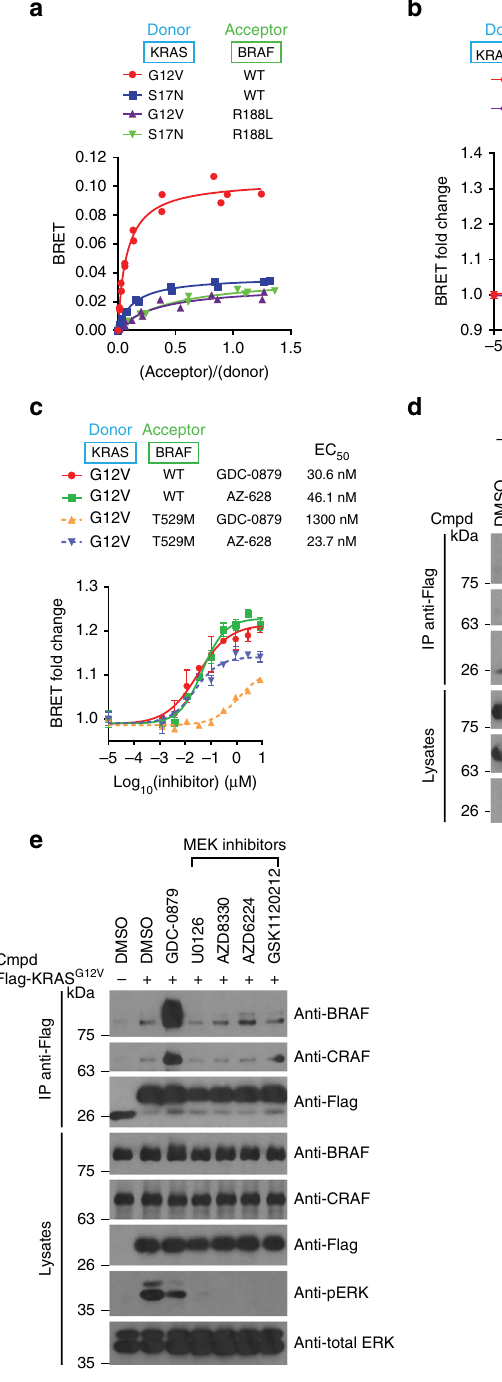
Fig. 1 RAF inhibitors promote RAS − RAF complex formation. a Validation of the KRAS − BRAF BRET biosensor by titration experiments. KRAS donor constructs comprised an N-terminal RlucII tag, while the BRAF acceptor constructs included an N-terminal GFP10 moiety. KRAS G12V − BRAF pair produced a strong and reproducible BRET signal that fi tted a hyperbolic function, indicating a speci fi c interaction. b The BRET signal emitted by the KRAS G12V − BRAF biosensors can be induced by RAF inhibitors in a dose-dependent manner. BRET fold-changes are presented separately for type I and type II inhibitors (left and right panel, respectively). c Mutation of the BRAF gatekeeper residue (T529M) in BRET probes abolishes GDC-0879 induced, but not AZ-628-induced KRAS G12V -BRAF interaction. EC 50 s for each dose-response curve are indicated. d Six bona fi de RAF inhibitors and three off-target inhibitors enhance the association of Flag-tagged KRAS G12V with endogenous BRAF and CRAF as measured by co-IP (left panel). GDC-0879 treatment also stimulates the association of NRAS G12V and HRAS G12V with endogenous BRAF and CRAF. Cells were treated with 10 µ M of the indicated compounds. e MEK inhibitors do not induce KRAS G12V -BRAF or KRAS G12V -CRAF complex formation as measured by co-IP. Cells were treated with 10 µ M of the indicated compounds. Error bars in dose-response curves correspond to mean values ± s.d. of technical duplicates of a representative biological triplicate. EC 50 s are the average of at least three independent repeats (Supplementary Data